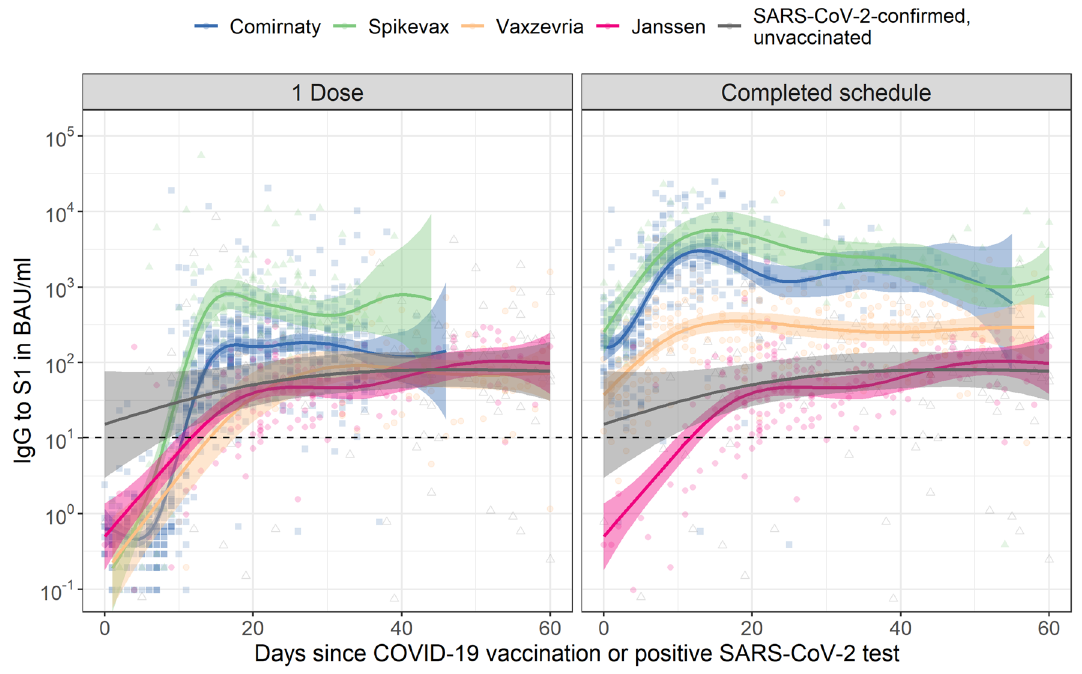
Figure 1. Spike S1 immunoglobulin G (IgG) kinetics following COVID-19 vaccination by number of doses and vaccine brand in SARS-CoV-2-naive adults aged 18 to 64 years old. The dashed horizontal line represents the threshold for seropositivity. Data for Janssen is duplicated across the two panels to enable direct comparison with the other vaccine brands after one dose and a completed vaccination schedule. For comparison, IgG concentrations following a positive SARS-CoV-2 PCR or antigen test in unvaccinated participants are shown alongside vaccination responses; data is duplicated in both panels (for details see Supplementary Table S3). Fit and 95% confidence bands are shown from a Generalized Additive Model, using penalized splines, with only time since dose in days as explanatory variable. For results of multivariable models, see Supplementary Table S1. BAU/mL: binding antibody units per mL; IgG: immunoglobulin